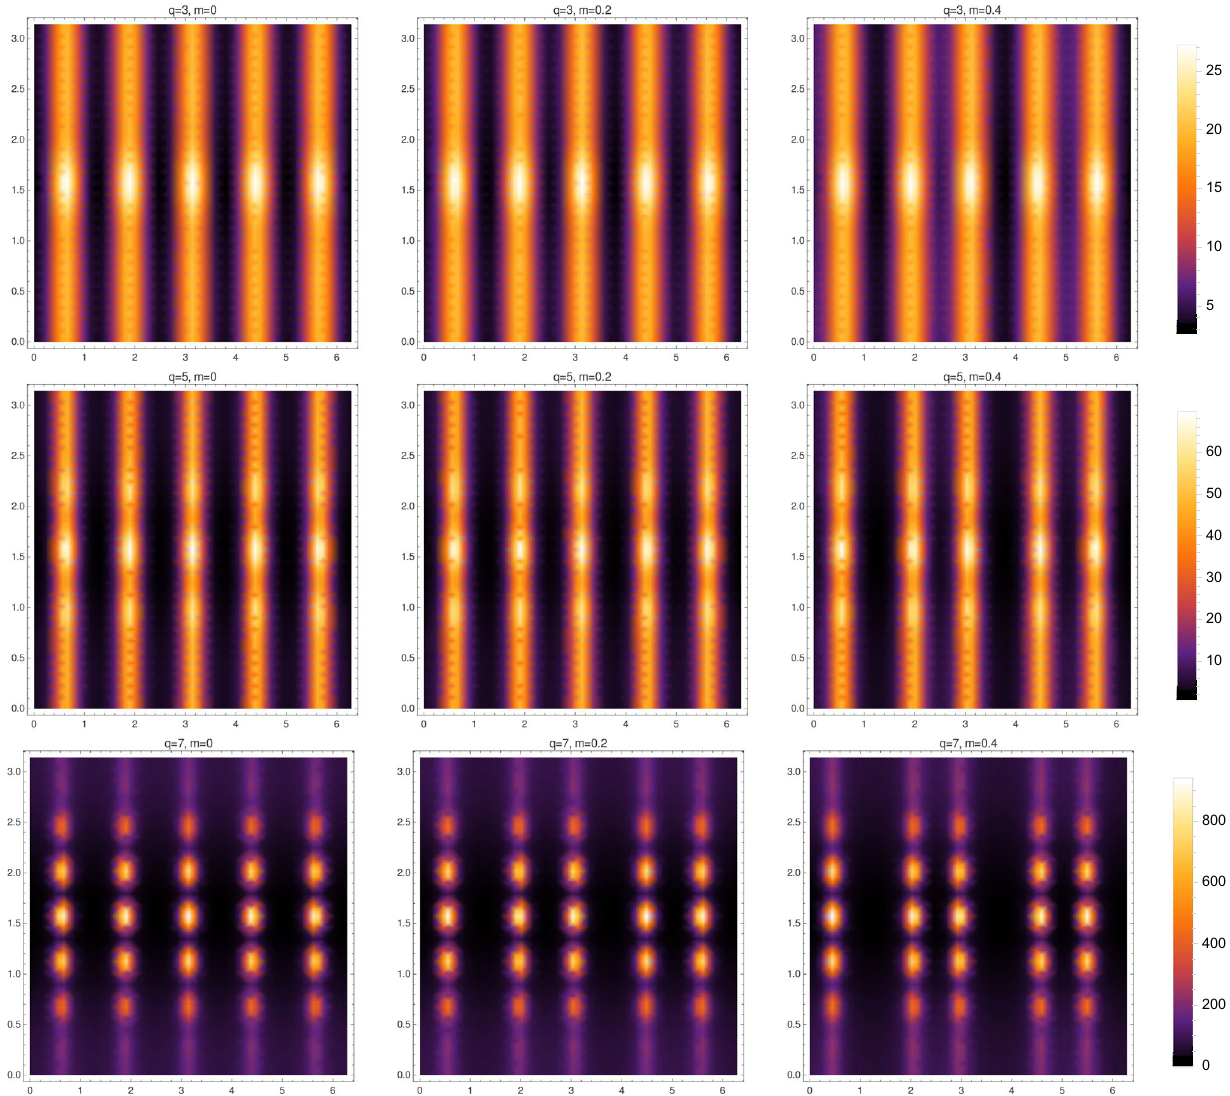
Fig. 2 Electric field, magnetic field and the current of two gauged solitons, with n = 2, m = 0, and p = q = 1. The electric and magnetic fields vanish in the center of the tubes while the current is completely contained inside these